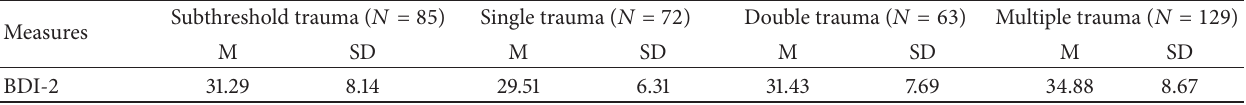
Table 5: Descriptive scores for BDI-2 and trauma groups.